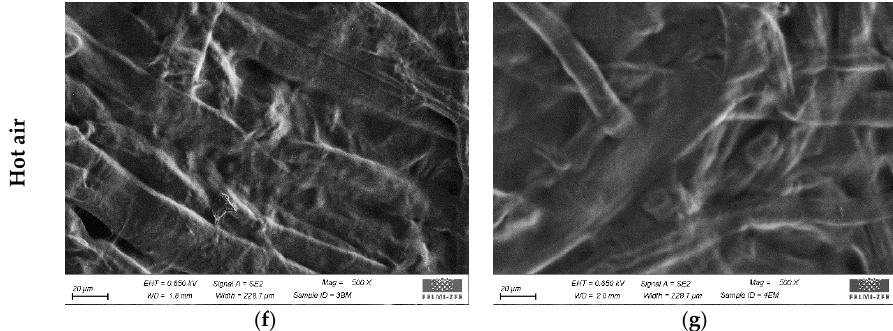
Figure 2. Visualized surface (SEM) features of uncoated raw paper and chitosan-coated samples dried using various methods: ( a ) Raw paper; ( b ) IR + Hot air (1 layer); ( c ) IR + Hot air (2 layers); ( d ) IR (1 layer); ( e ) IR (2 layers); ( f ) Hot air (1 layer); ( g ) Hot air (2 layers).